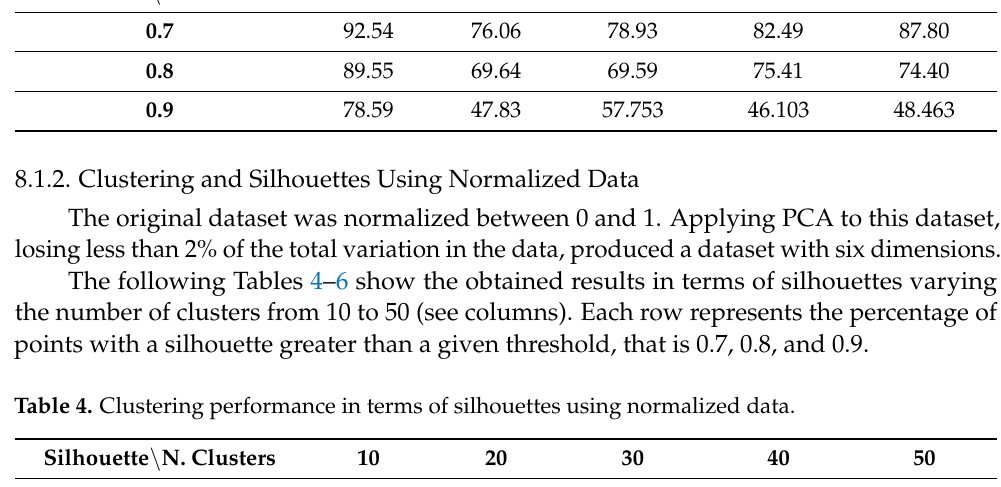
Table 3. Clustering performance in terms of silhouettes using the reduced dataset with SPQR. Silhouette \ N. Clusters